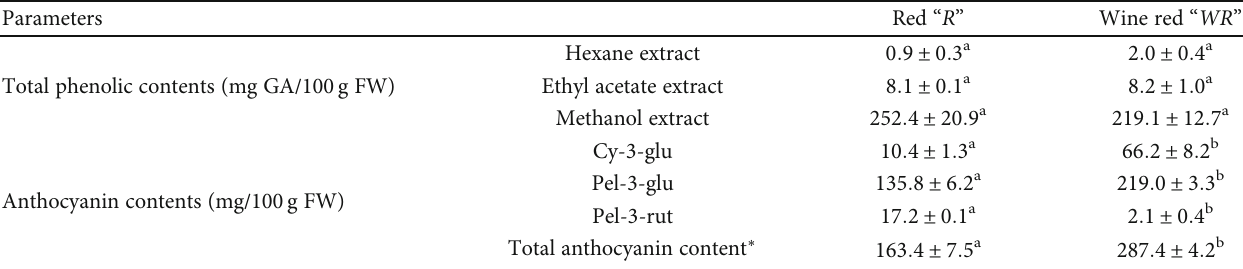
Anthocyanin contents (mg/100g FW) Values are the mean ± SD ( n = 3 ). Di ff erent superscript letters across a row indicate that the value is signi fi cantly di ff erent at the 95% con fi dence level. ∗ Values expressed as cyanidin-3-glucoside